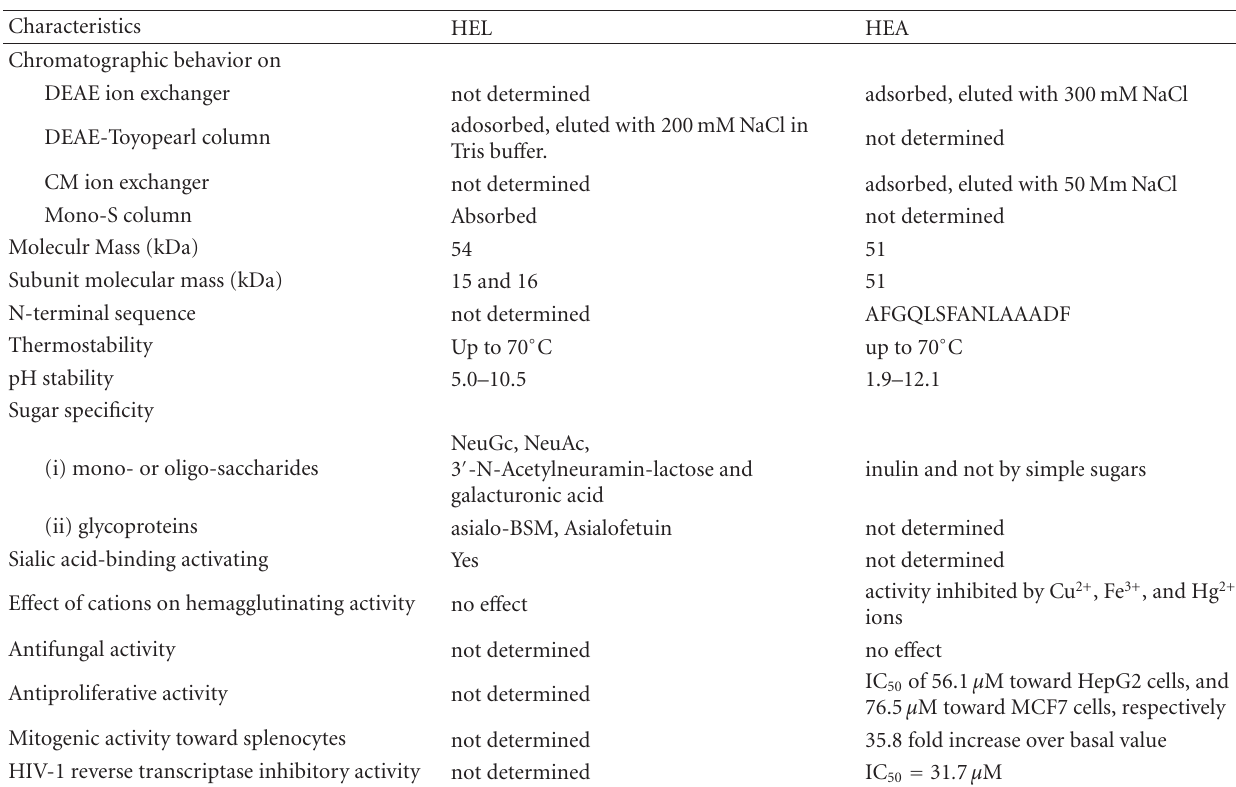
Table 6: Comparison of characteristics of HEL [17] and HEA (this